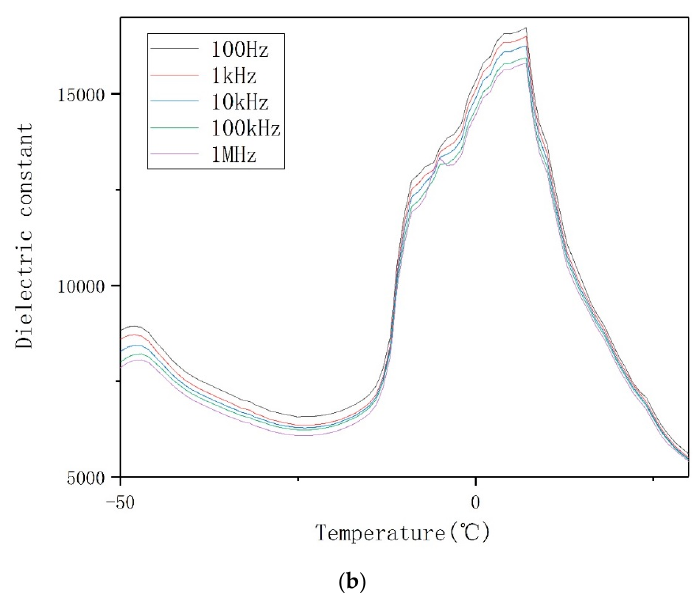
Figure 2. ( a ) Dielectric constant ε r of potassium tantalum niobate (KTN) and Fe: KTN crystals changes with temperature. ( b ) Temperature dependence of the dielectric constant of Fe: KTN crystal at different frequencies.